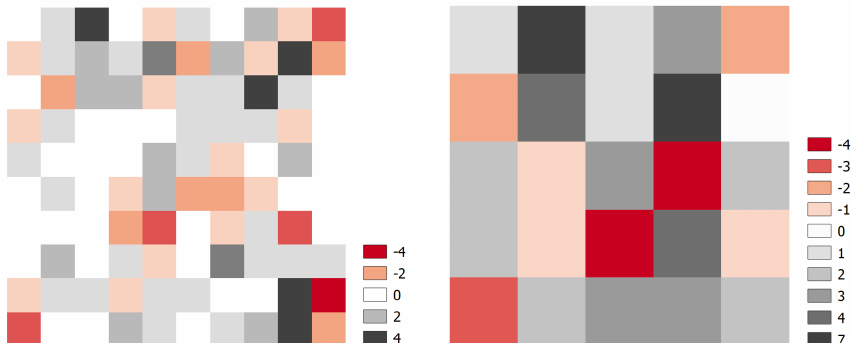
Figure 6. Difference between TLS tree count and field tree count. The average tree count per grid cell in the field survey is not significantly different from the average tree count in the TLS survey ( p > 0.05). For this analysis only trees with DBH > 0.05 m ( − 0.007 m mean absolute error (MAE)) were used.